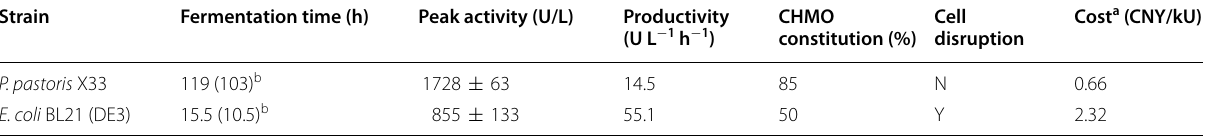
‑Mut production in E. coli and P. Acineto